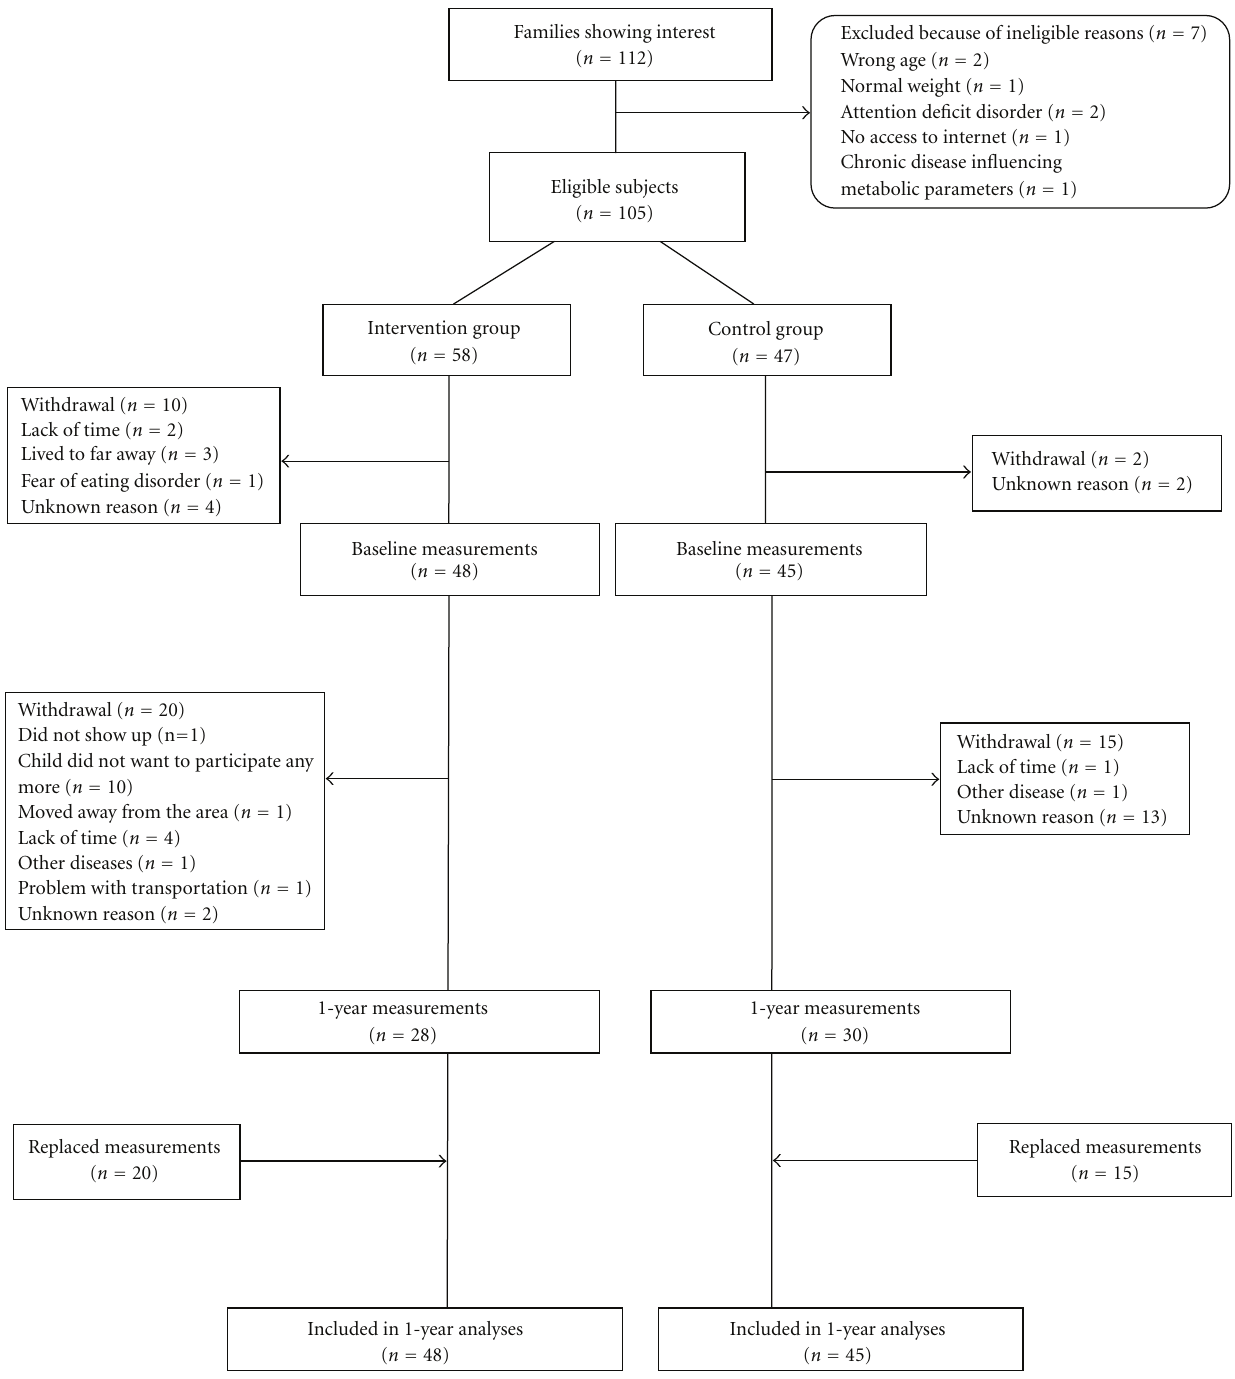
Figure 1: Flowchart of participants in a 1 year randomized controlled intervention study with overweight and obese children.